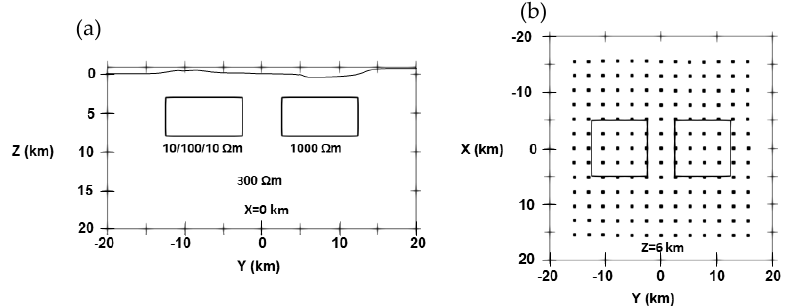
Figure 17. Panels ( a ) and ( b ) show the isotropic and anisotropic blocks model at x = 0 km and z = 6 km, respectively. The black dots represent the MT receivers.